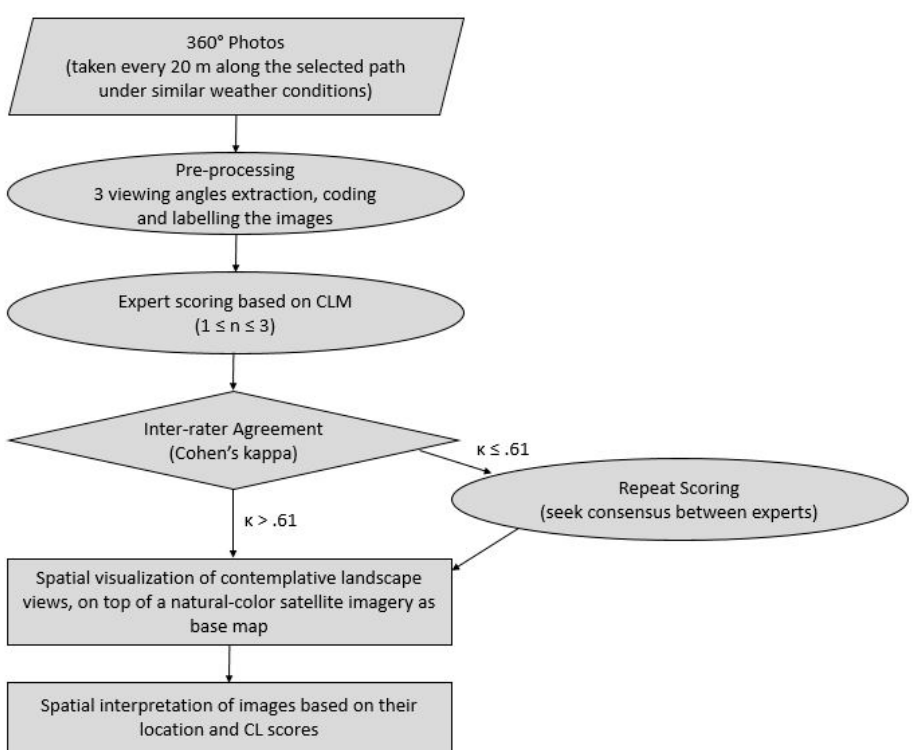
Figure 4. Methodology flow chart.